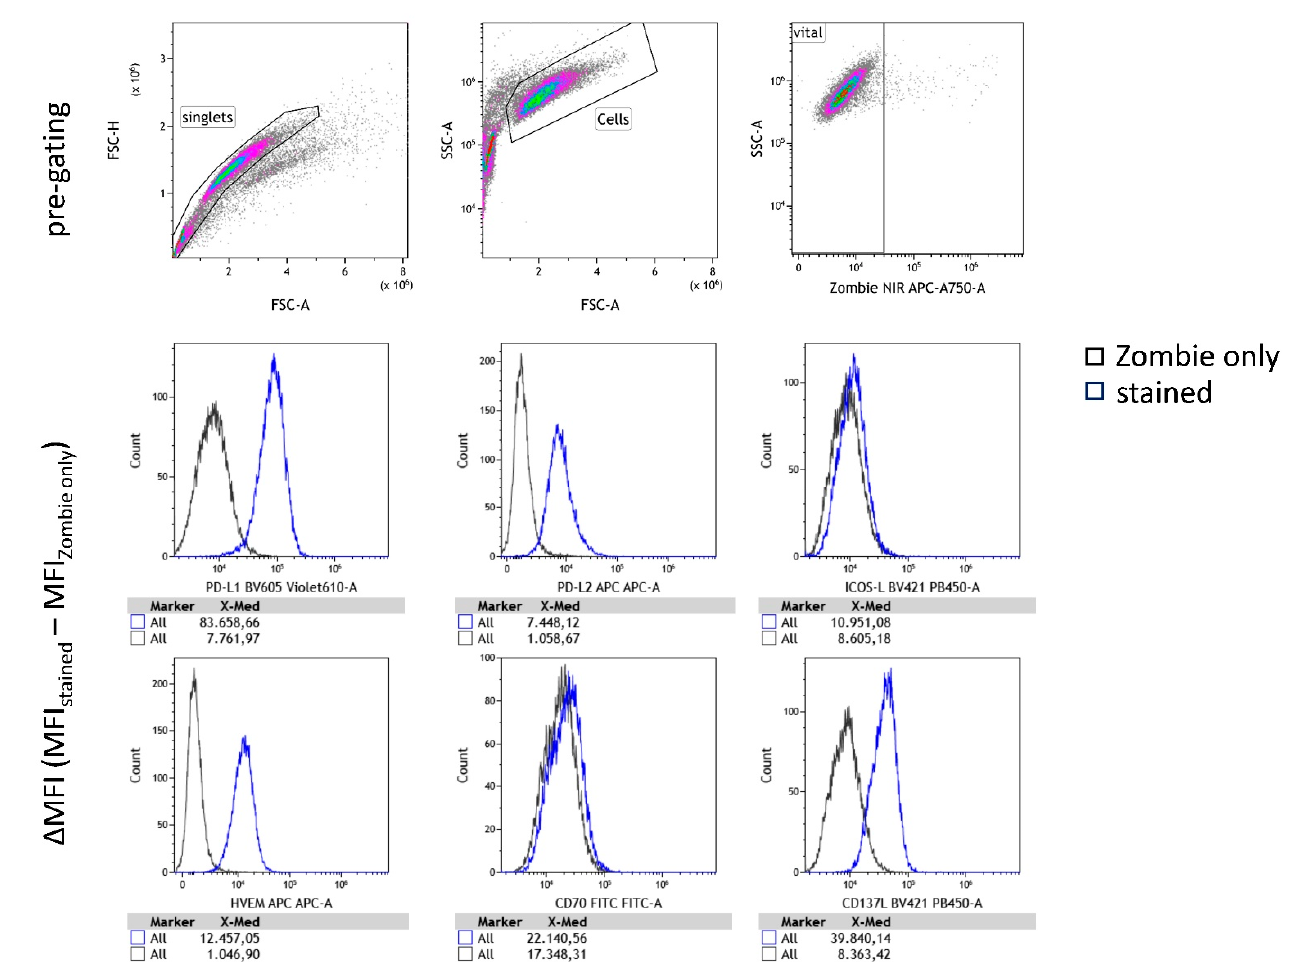
Figure A2. Exemplary gating strategy for analyses of cell surface expression of immune checkpoint molecules via multicolor flow cytometry. Pre-gating: identification of single cells (“singlets”), differentiation of cells from debris (“cells”) and vital cells via Zombie live/dead stain (“vital”). X-Med of various antibodies for immune checkpoint molecules was taken and X-Med values of Zombie only stained samples was subtracted for Δ MFI calculation.